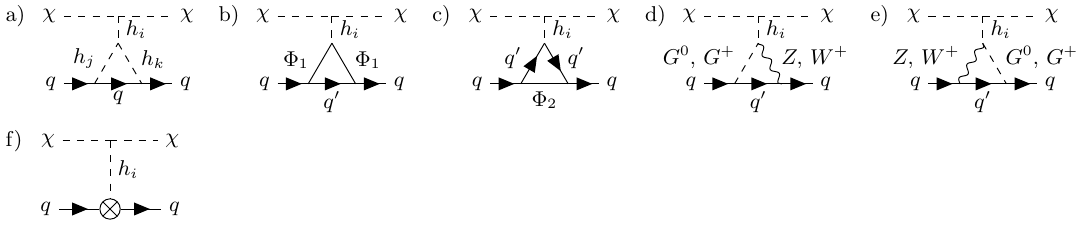
Figure 4 . The EW NLO corrections to the upper vertex. The indices i, j, k = 1 , 2 indicate the respective Higgs mediator h 1 , h 2 . The field insertion is given by Φ 1 = { χ, G (0 , ± ) } .